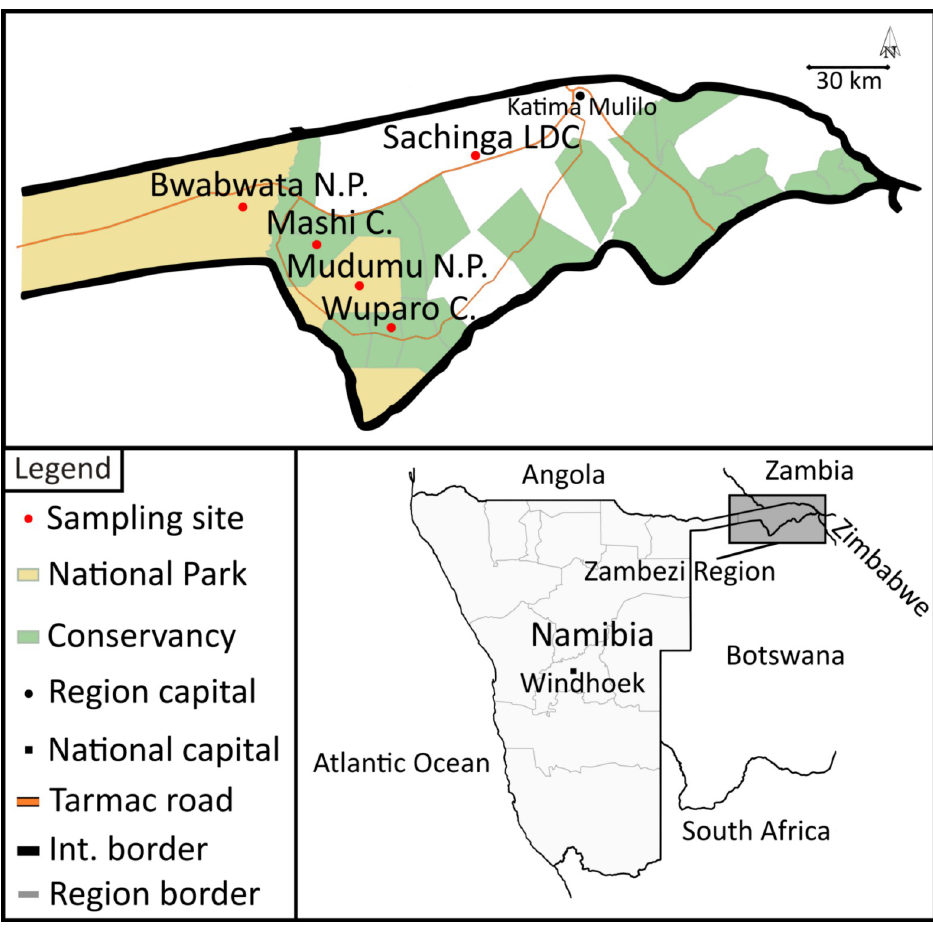
Fig 1. Schematic map of mosquito-sampling sites in Namibia. Samples were retrieved from Bwabwata and Mudumu National Parks, Wuparo and Mashi Conservancies and Sachinga Livestock Development Centre (Sachinga LDC). The map base layer is based on https://www.naturalearthdata.com, and the map’s details are based on